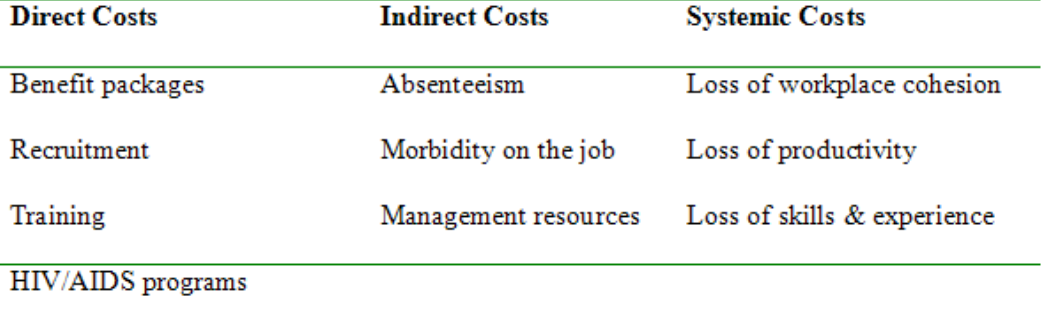
Table 5. Economic impact of HIV/AIDS on NOUN’s